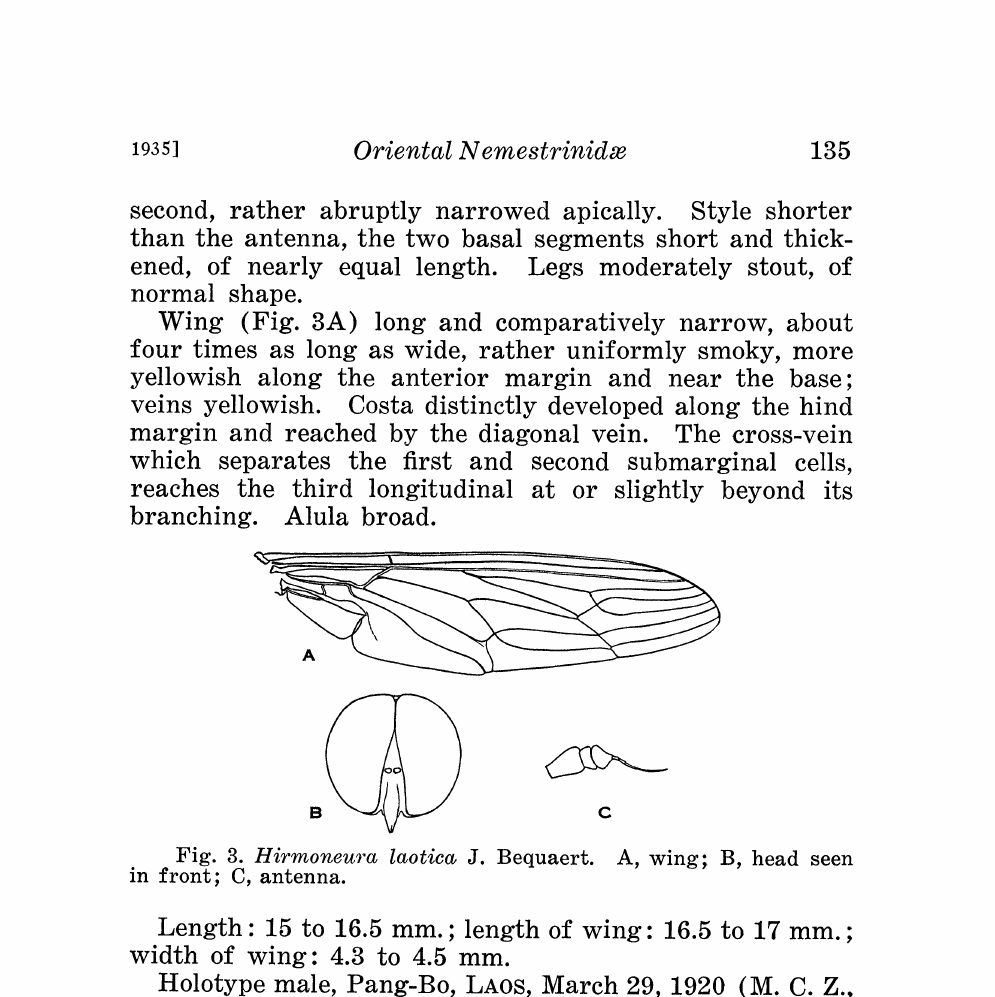
Fig. 3. Hirmoneura laotic J. Bequaert. A, wing; B, head seen in ront; C, antenna. Length: 15 to 16.5 mm. length oi wing: 16.5 to 17